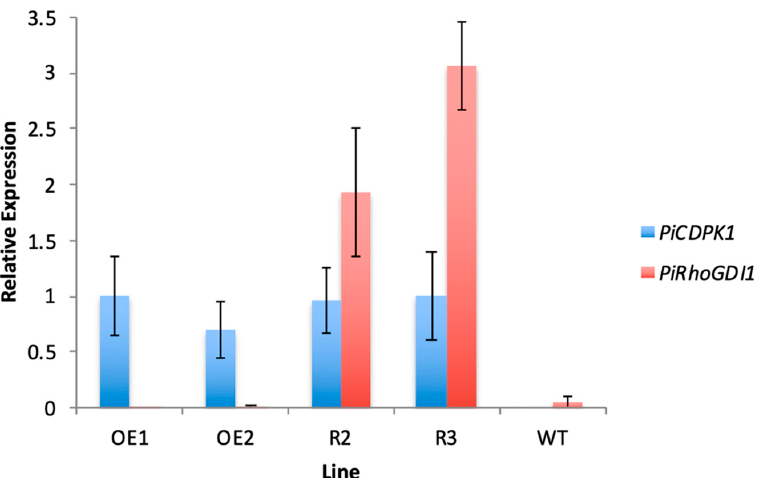
Figure 5. Quantitative PCR results showing relative expression of the PiRhoGDI transgene com ‐ pared with the PiCDPK1 transgene in pollen from stable transgenic tobacco lines. Plant lines shown: OE1 and OE2 (transgenic lines expressing PiCDPK1 ‐ GFP alone), Rescue 2 and Rescue 3 (transgenic lines expressing PiCDPK1 ‐ GFP and PiRhoGDI1) and WT (wild type). Results are normalized to the ribosomal protein 25 (L25) internal reference gene and the OE1 line is used as the control (expression level of 1.0). Data are presented as means ± SE from three biological replicates.